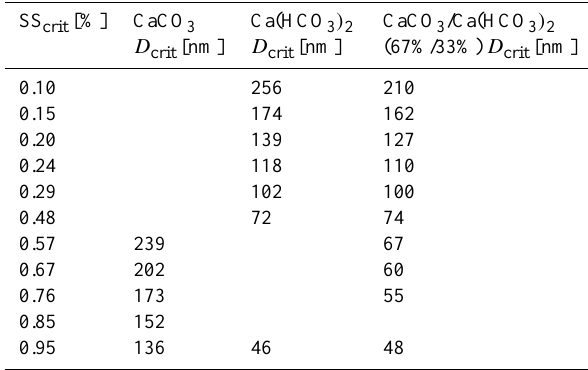
Table 4. Critical parameter of CCN activation observed in the lab- oratory study.